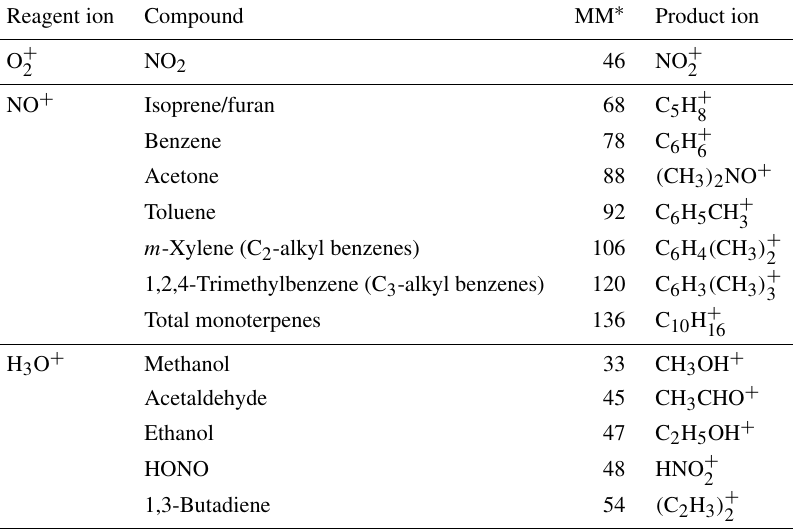
Table 2. The compounds measured by the SIFT-MS and their corresponding reagent ions, molecular masses and product ion chemical formulas.